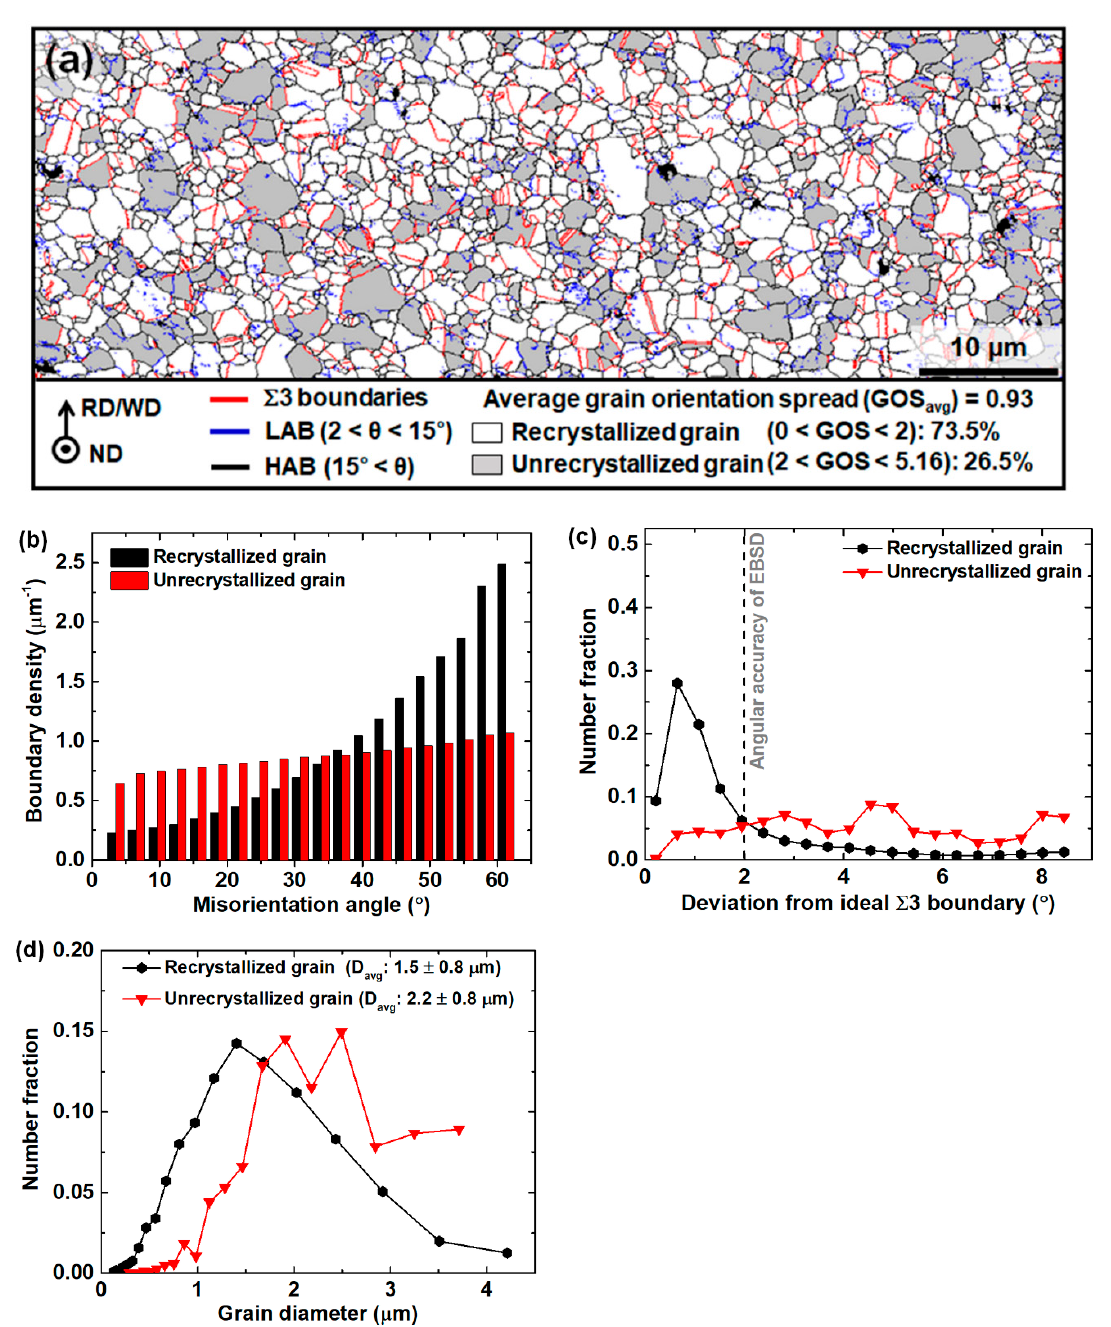
Figure 3. Microstructure partitioning in stir zone. ( a ) Grain orientation spread map and microstructure and microstructural characteristics of recrystallized and unrecrystallized grains: ( b ) misorientation angle distribution, ( c ) misorientation deviations measured along ideal Σ 3 twin boundaries, and ( d ) grain diameter distributions (including annealing twins).